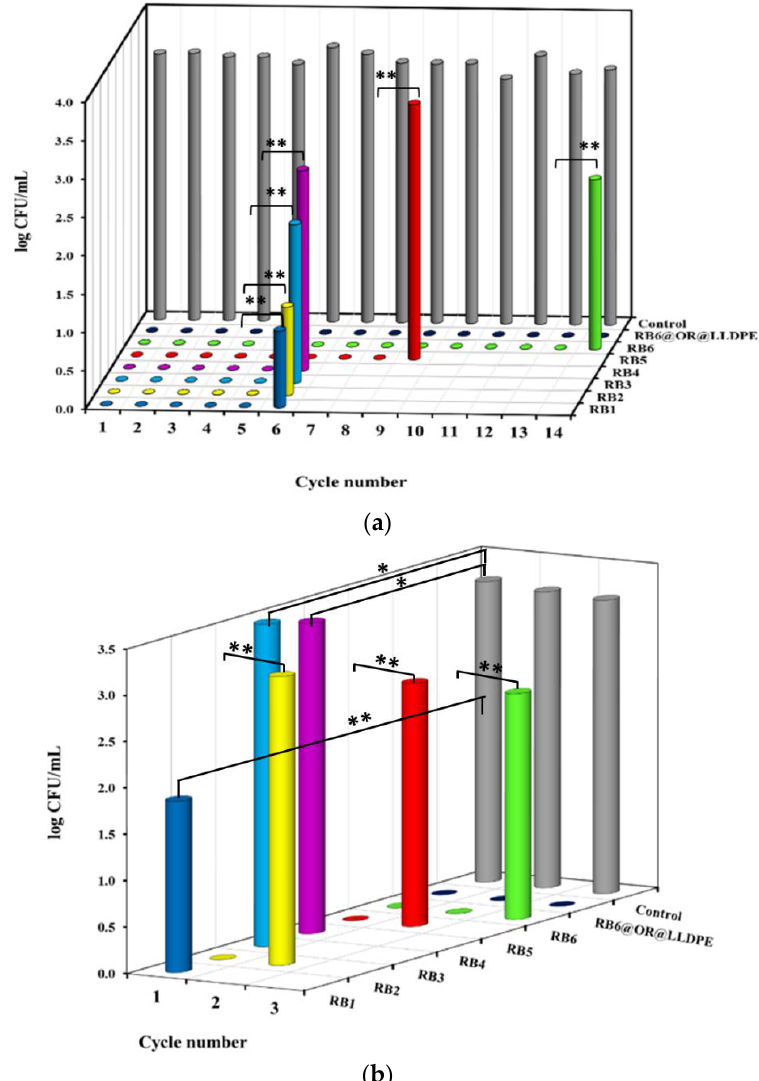
Figure 7. Antibacterial activity of RB1–RB6 and RB6@OR@LLDPE against S. aureus under illumination at a fluence rate of 39.5 mW cm −2 ( a ), and in the dark ( b ), at 25 °C for 5 min. Control—untreated bacterial cells. Figures at x-axis show the number of usage cycles. Control— S. aureus after 5 min incubation. Results with no statistical difference are marked by one asterisk and statistically different results ( p < 0.05) are marked by two asterisks.